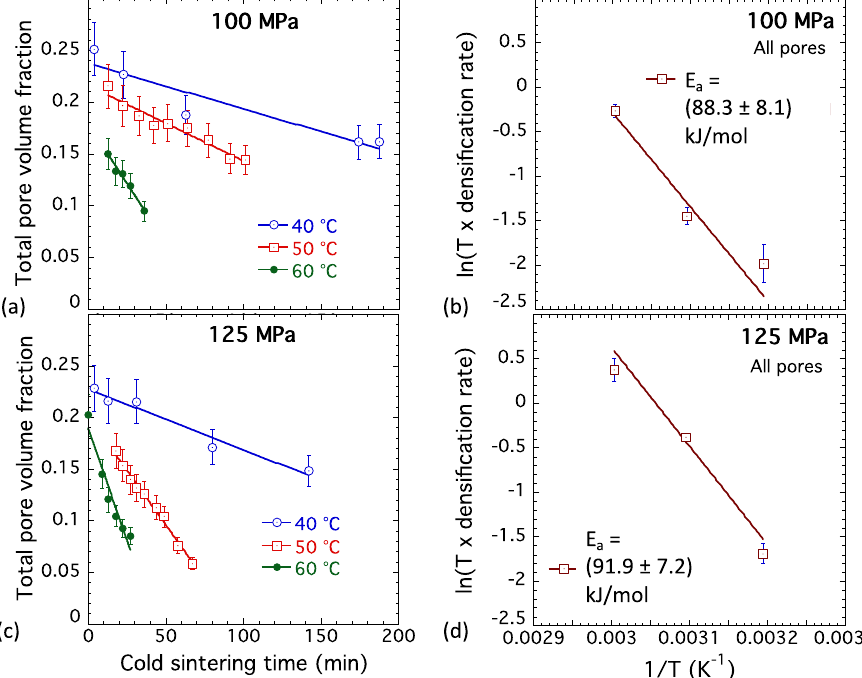
Figure 13. Arrhenius analyses of CSP for ( a , b ) p = 100 MPa; ( c , d ) p = 125 MPa, using data for total pore volume fraction at 40 °C, 50 °C, and 60 °C. The activation energy is with respect to loss of porosity per mole of solid KDP that fills the pore space during densification. Vertical bars are computed standard uncertainties of the straight-line fits.